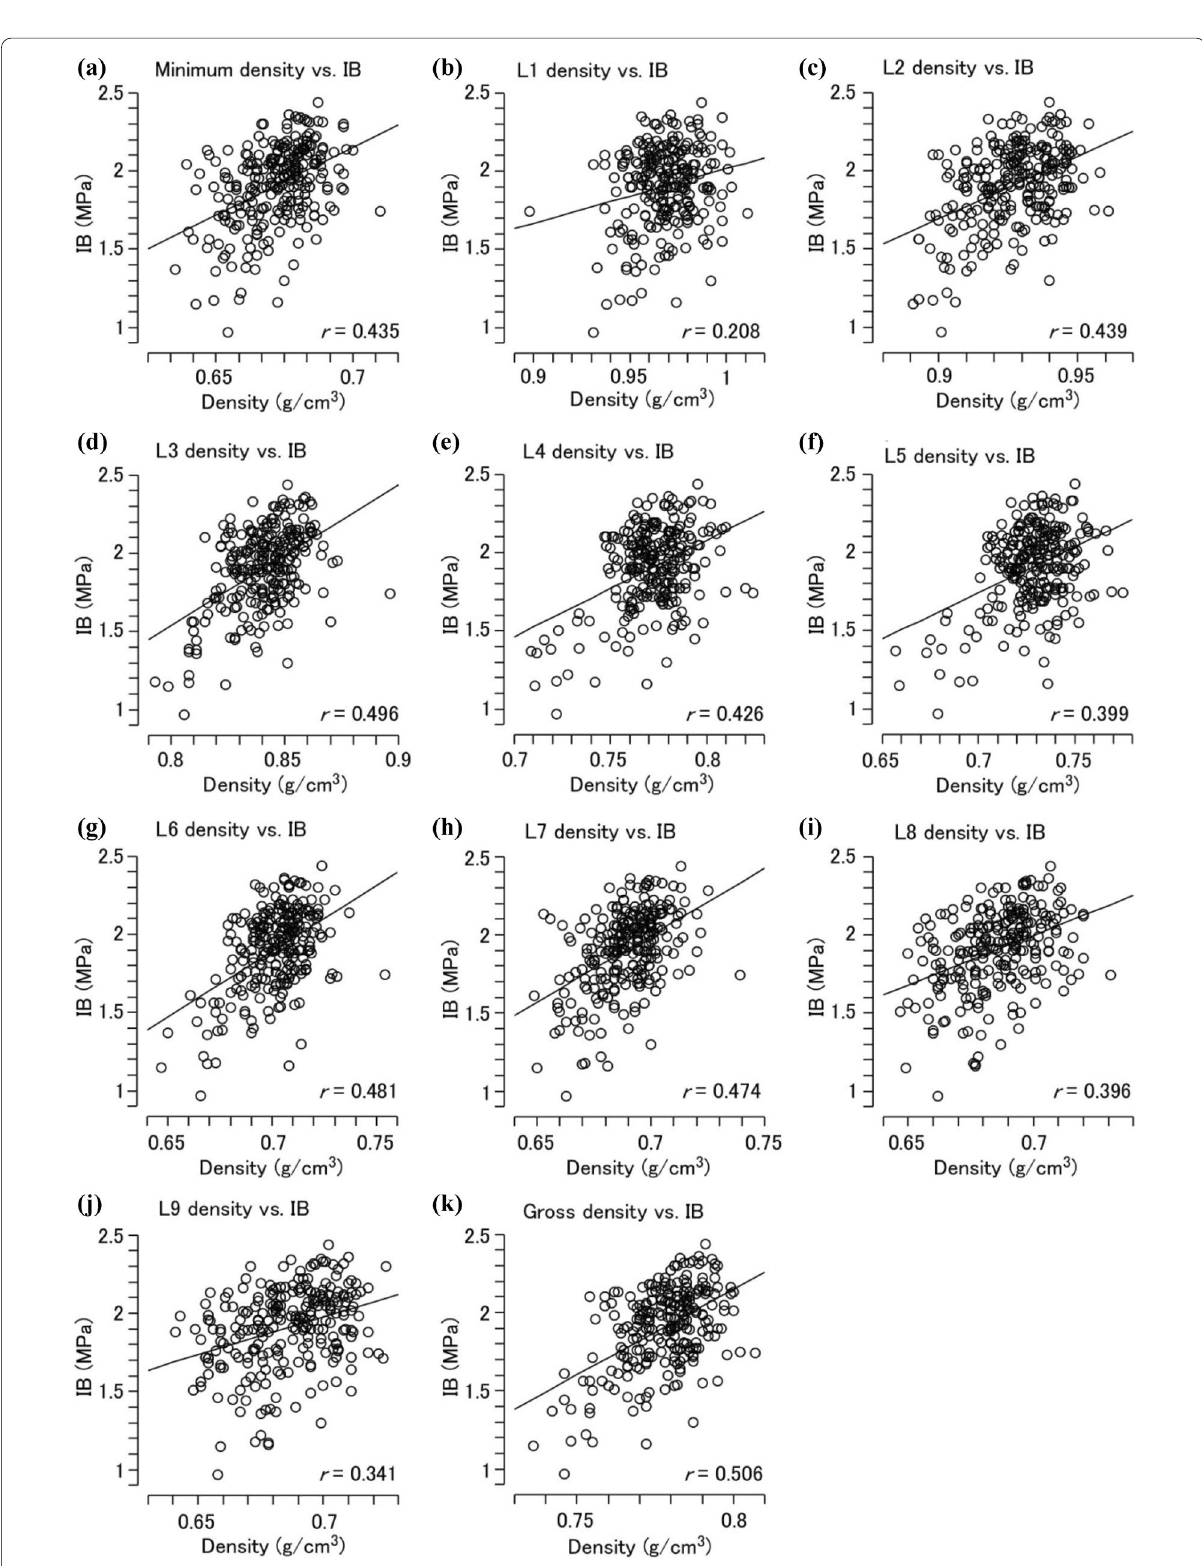
Fig. 4 The relationship between the layer densities and internal bond (IB). a Minimum density vs. IB. b L1 density vs. IB. c L2 density vs. IB. d L3 density vs. IB. e L4 density vs. IB. f L5 density vs. IB. g L6 density vs. IB. h L7 density vs. IB. i L8 density vs. IB. j L9 density vs. IB. k Gross density vs.